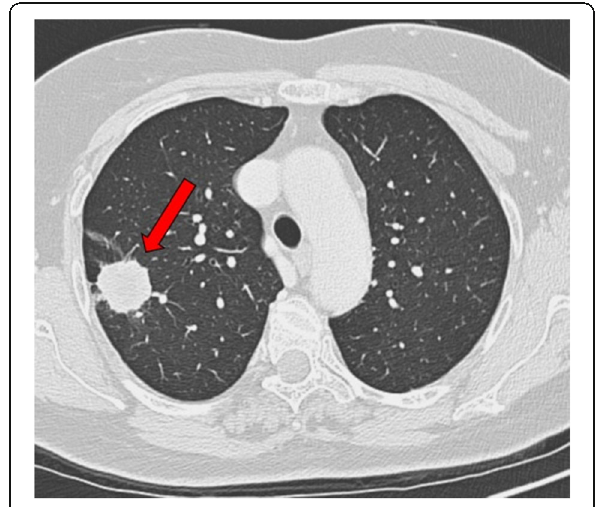
Fig. 3 CT scan of chest performed in January 2019 to exclude pulmonary embolism, showing a mass of 28 mm in the right upper lobe (case report